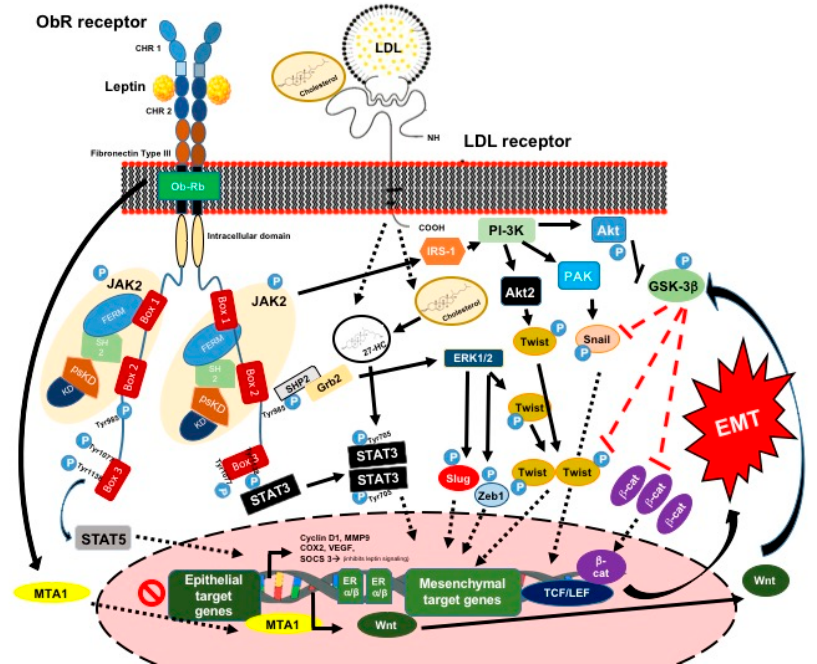
Figure 3. Schematic representation of leptin-induced signaling pathway. Leptin, cholesterol and low-density lipoprotein (LDL) particles interact with their respective receptors, which trigger a cascade of signaling events promoting EMT